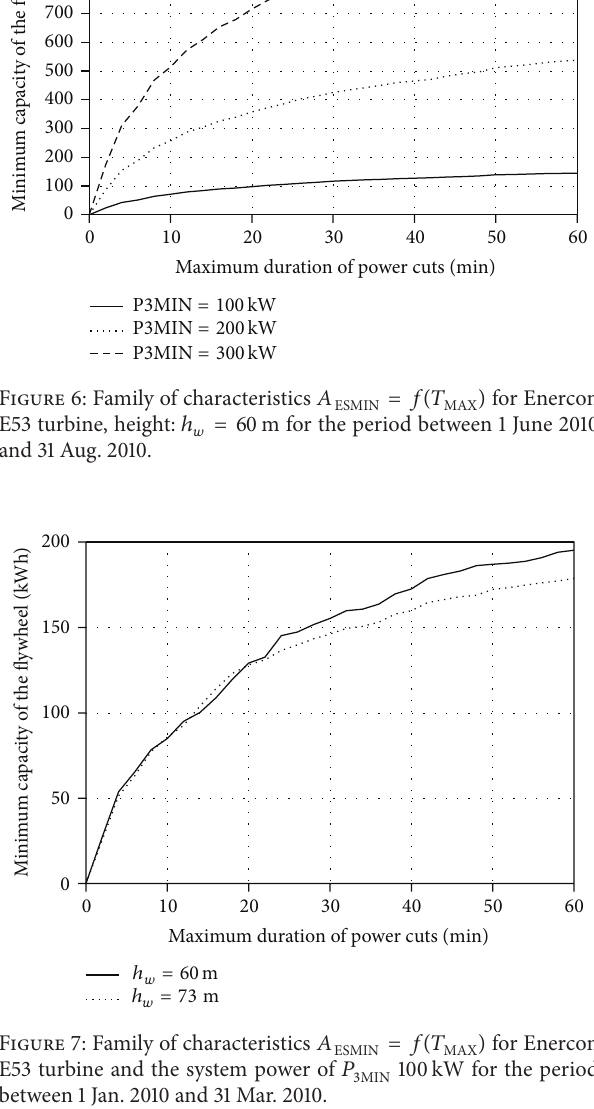
Figure 7: Family of characteristics 𝐴 E53 turbine and the system power of 𝑃 3 between 1 Jan. 2010 and 31 Mar.